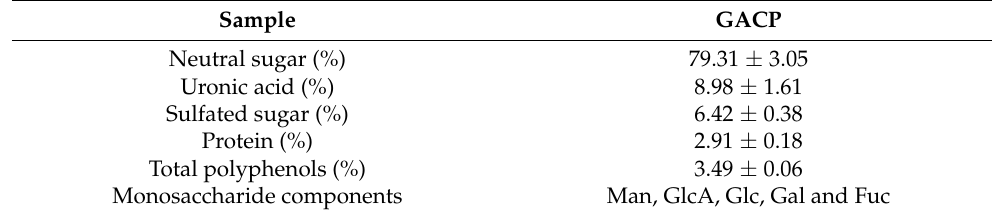
Table 1. Results of chemical composition for GACP.